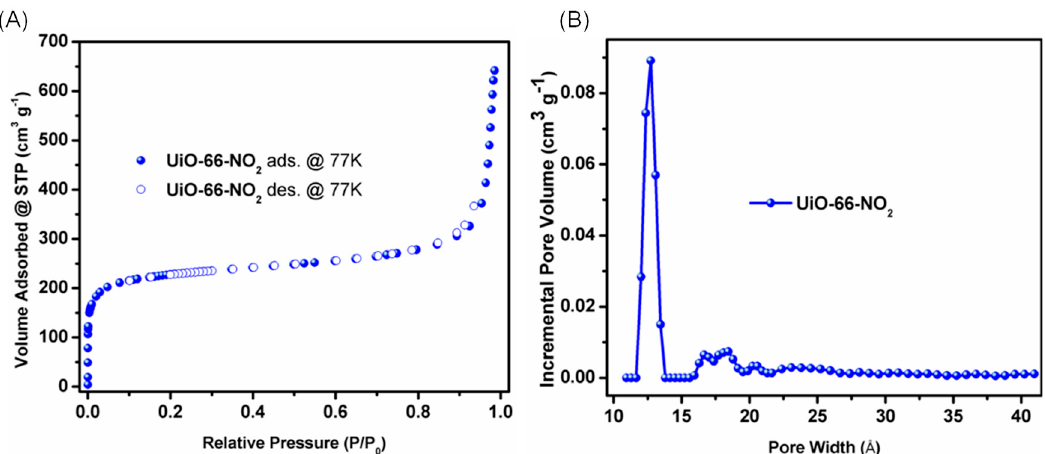
Figure 2. ( A ) N 2 sorption isotherms of UiO-66-NO 2 at 77 K and ( B ) pore-size distribution based on a non-local density functional theory (NLDFT) model.